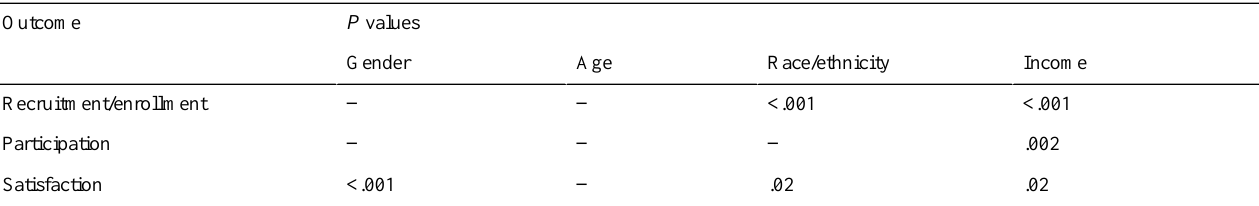
Table 4. Statistically significant comparisons of recruitment category, participation, and satisfaction by demographic